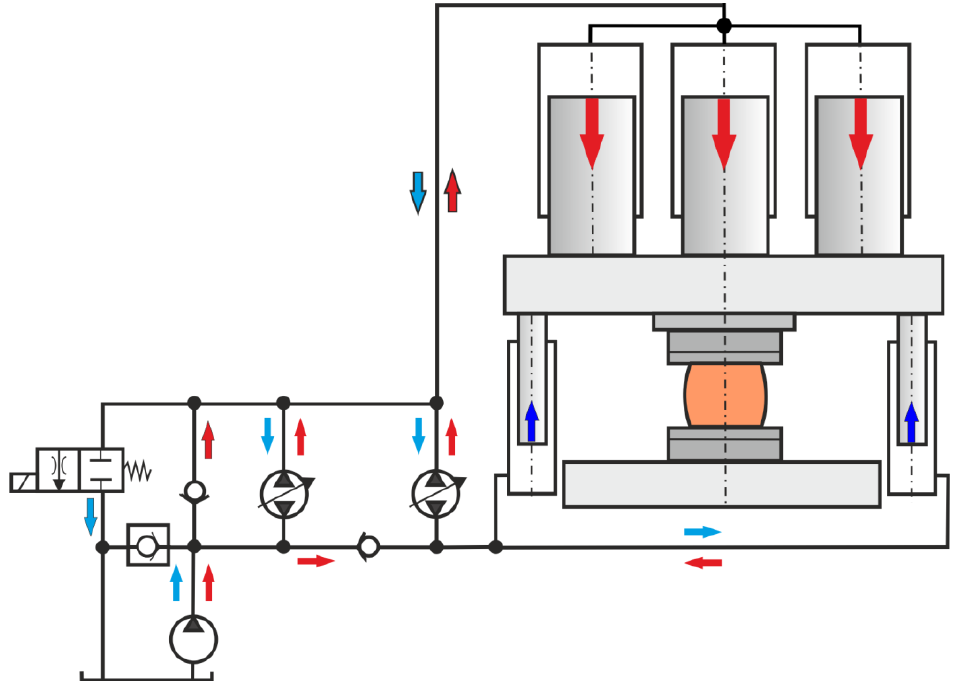
Figure 2. Diagram scheme of a hydraulic forging press with pumps connected in series and in parallel.